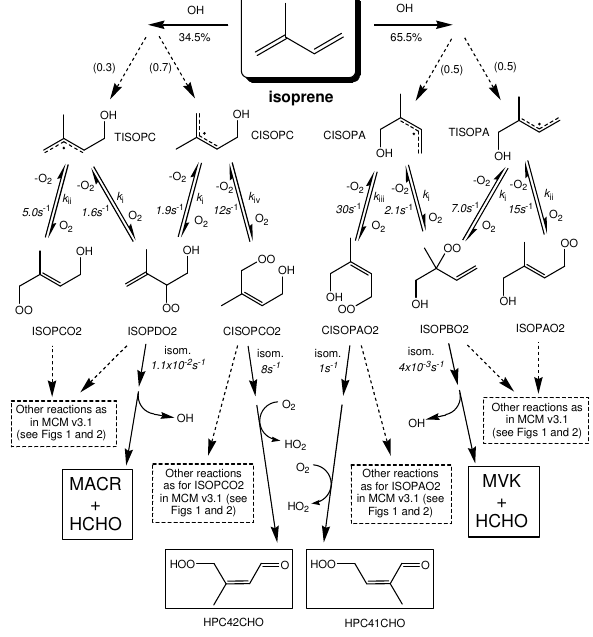
Fig. 6. Schematic representation of the OH initiated degradation Figure 6. Schematic representation of the OH initiated degradation of isoprene to first 3 of isoprene to first generation products in Mechanisms 3a and 3b. generation products in Mechanisms 3a and 3b. With the exception of the initial OH addition 4 With the exception of the initial OH addition ratio, the mecha- ratio, the mechanism and parameters are taken from the theoretical study of Peeters et al. 5 nism and parameters are taken from the theoretical study of Peeters (2009), and facilitate a full appraisal of the impact of the RO 2 isomerisation chemistry on HO x 6 et al. (2009), and facilitate a full appraisal of the impact of the recycling. k i = 1.5 x 10 -12 cm 3 molecule -1 s -1 ; k ii = 3.0 x 10 -13 cm 3 molecule -1 s -1 ; k iii = 1.4 x 10 - 7 RO 2 isomerisation chemistry on HO x recycling. k i = 1.5 × 10 − 12 12 cm 3 molecule -1 s -1 ; k iv = 1.0 x 10 -12 cm 3 molecule -1 s -1 . The initial OH addition ratio is 8 cm 3 molecule − 1 s − 1 ; k ii = 3.0 × 10 − 13 cm 3 molecule − 1 s − 1 ; unchanged from MCM v3.1 (see section 2 and Figure 1), but is very close to that calculated 9 k iii = 1.4 × 10 − 12 cm 3 molecule − 1 s − 1 ; k iv = 1.0 × 10 − 12 cm 3 by Peeters et al. (2009). 10 molecule − 1 s − 1 . The initial OH addition ratio is unchanged from MCM v3.1 (see Sect. 2 and Fig. 1), but is very close to that calcu- lated by Peeters et al.